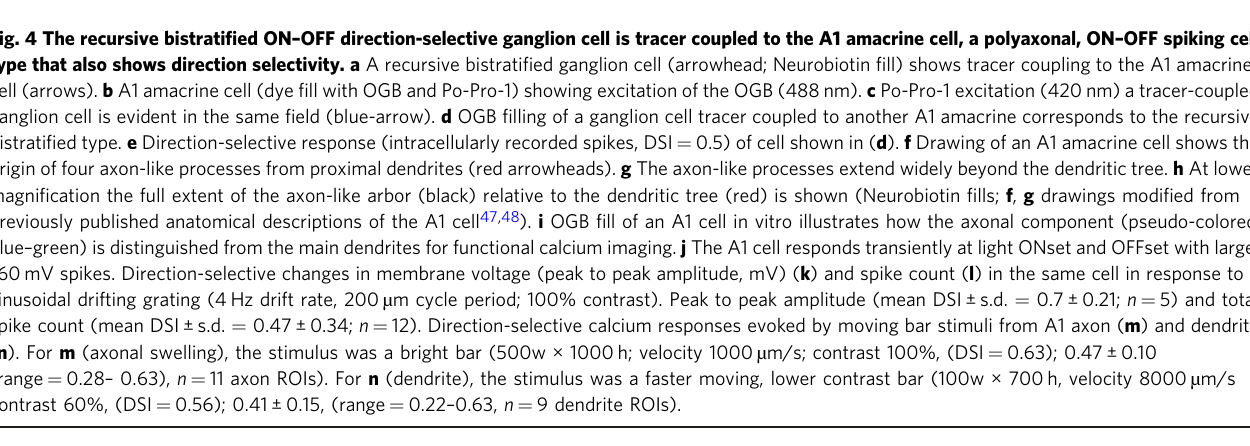
Fig. 4 The recursive bistrati fi ed ON – OFF direction-selective ganglion cell is tracer coupled to the A1 amacrine cell, a polyaxonal, ON – OFF spiking cell type that also shows direction selectivity. a A recursive bistrati fi ed ganglion cell (arrowhead; Neurobiotin fi ll) shows tracer coupling to the A1 amacrine- cell (arrows). b A1 amacrine cell (dye fi ll with OGB and Po-Pro-1) showing excitation of the OGB (488 nm). c Po-Pro-1 excitation (420 nm) a